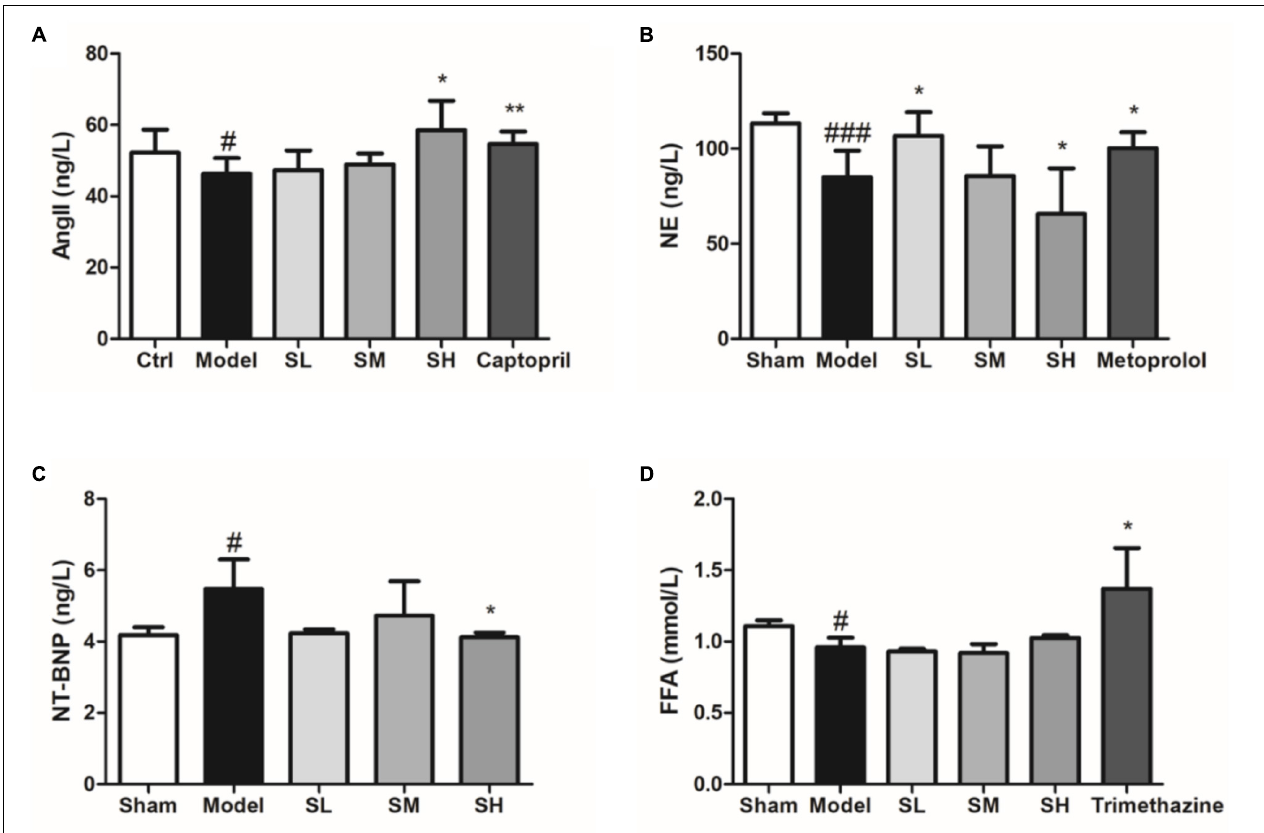
FIGURE 9 | Serum Ang II (A) , NE (B) , NT-BNP (C) , and FFA (D) of Schisandra treated AMI mice. All data are shown as the mean ± SD. # P < 0.05, ### P < 0.001 vs. Sham group; ∗ P < 0.05, ∗∗ P < 0.05 vs. Model group.